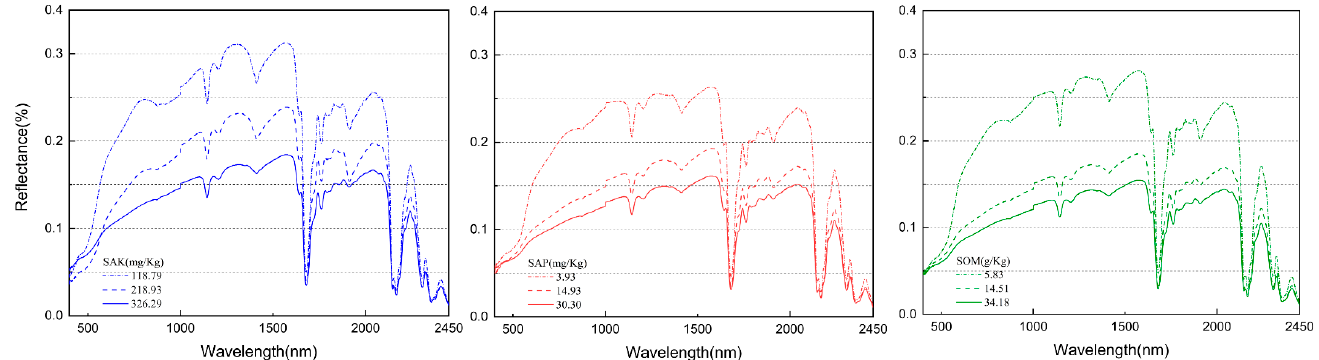
Figure 4. Spectral signatures of three soil nutrients’ contents under different classes.